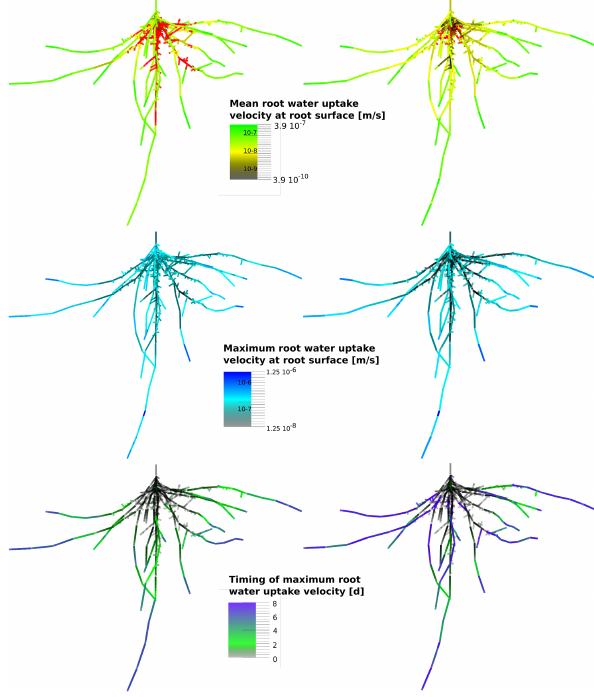
Figure 7. Root water uptake dynamics in a fixed root geometry with two different hydraulic parameterizations. Results were obtained with the “aRoot” model for one root system containing young roots only (left, least efficient) and a mixture of 40% of basal mature and 60% of apical young roots (right, most efficient). (Top) Time- averaged root water uptake rate along the root system. Regions with negative net uptake (hydraulic lift or bleeding) are depicted in red, independent of the actual amount of water released. (Centre) Mag- nitude and (bottom) timing of maximum uptake velocity along the root system. Please note the log-scale of the colour bar in the top and centre